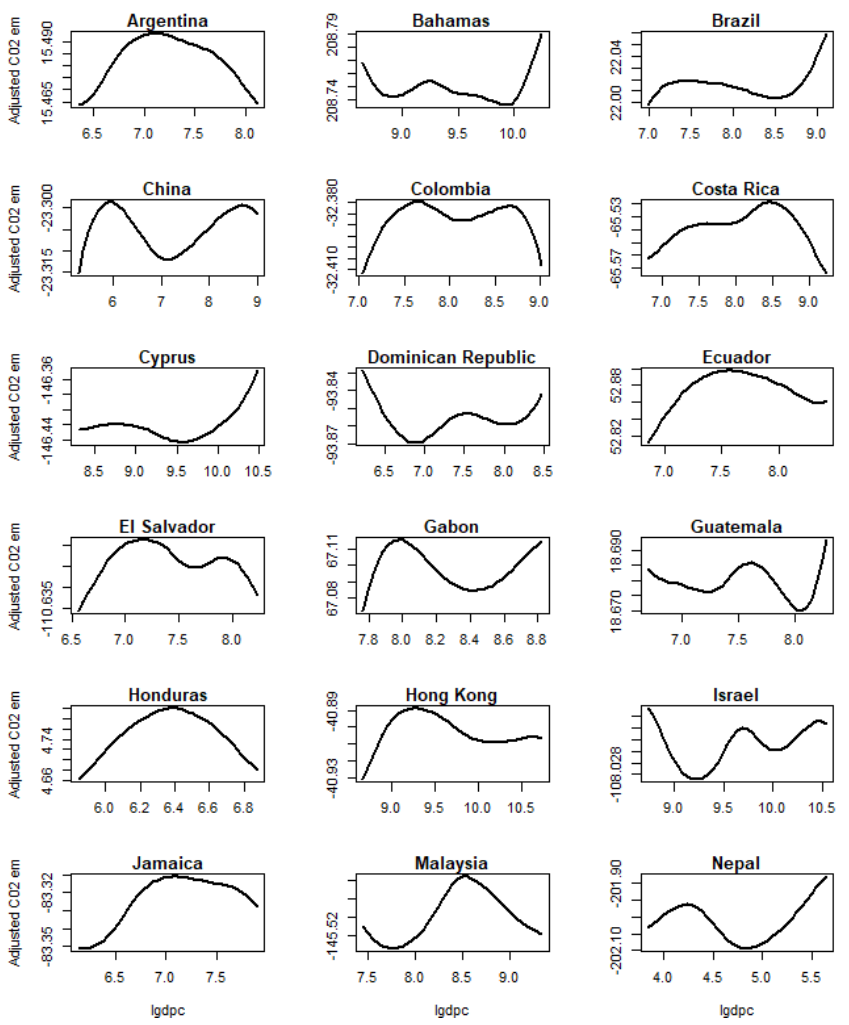
Figure 3. Nonparametric estimates of income-CO 2 emissions for the non-OCDE